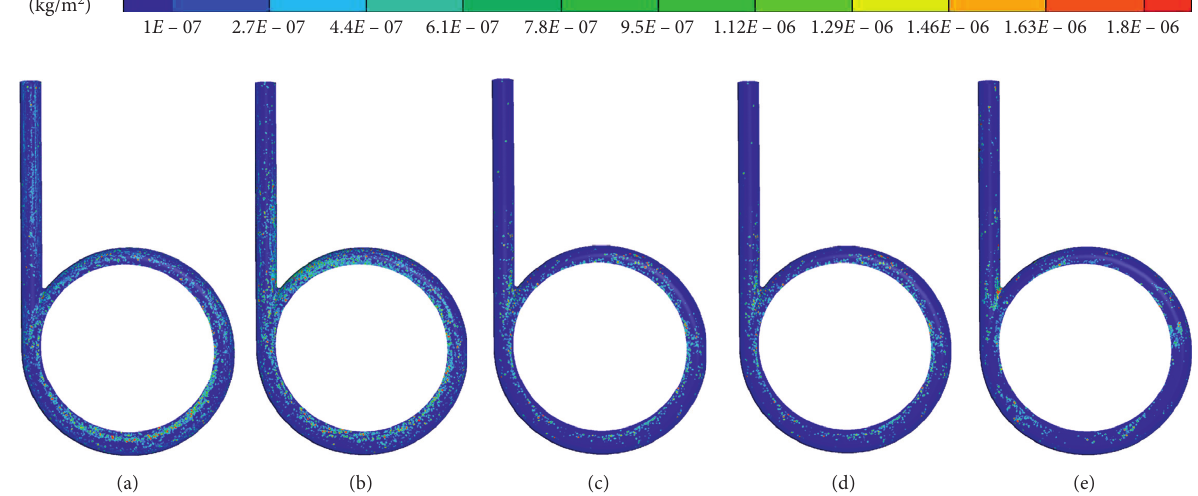
Figure 11: Volute wear clouds with different particle sizes. (a) d � 0.048mm, (b) d � 0.106mm, (c) d � 0.15mm, (d) d � 0.27mm, and (e) d � 0.425mm.